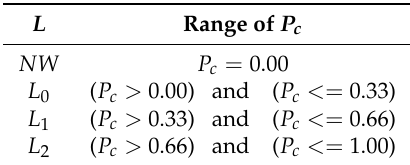
Table 2. Warning messages’ severity